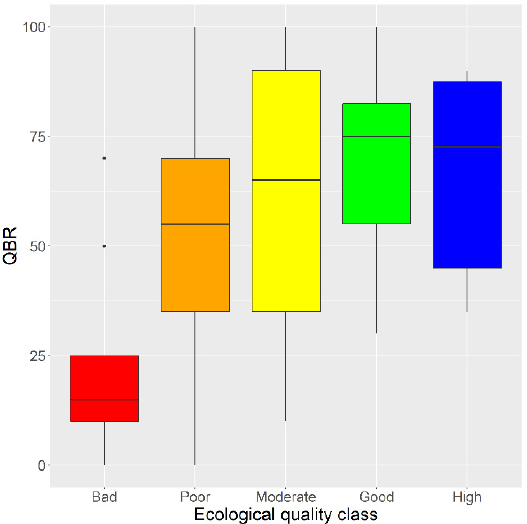
Figure 8. Box plots of QBR score per class of hydromorphological modification (HMS).